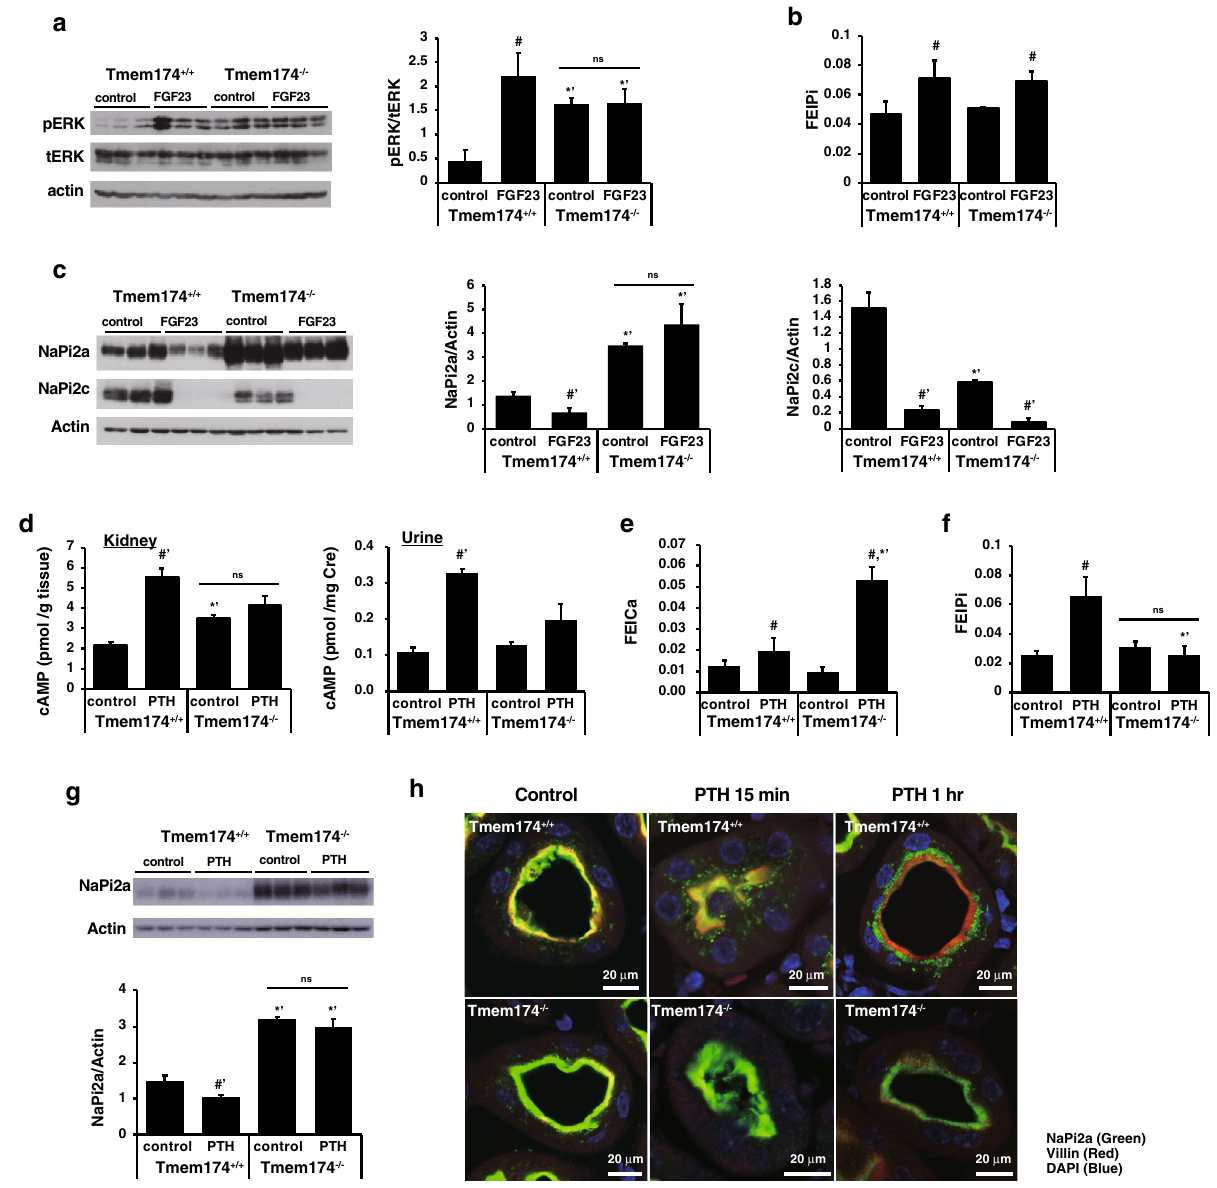
Figure 9. Abnormal regulation of phosphaturic action to renal NaPi2a Pi transporter in Tmem174 −/− mice. Tmem174 +/+ and Tmem174 −/− mice (9–10-week-old mice, n = 3–5, respectively) were fed a 0.02% low Pi diet for 7 days to reduce endogenous FGF23. Exogenous FGF23 expression was performed using the Naked- DNA method, as described previously 26 . ( a ) Western blotting analysis of total ERK1/2 and phosphorylation ERK1/2 in Tmem174 +/+ and Tmem174 −/− mice. Each lane was loaded with 20 μg of the whole homogenate. Values are mean ± SE. # p < 0.05 vs control of the same genotype, *’ p < 0.01 vs same treatment of Tmem174 +/+ mice. ns not significant. ( b ) FEIPi. Values are mean ± SE. # p < 0.05 vs control of the same genotype. ( c ) Western blot analysis of NaPi transporters in Tmem174 +/+ and Tmem174 −/− mice. Each lane was loaded with 20 μg of BBMVs. Actin was used as an internal control. *’ p < 0.01 vs same treatment of Tmem174 +/+ mice. Values are mean ± SE. #’ p < 0.01 vs control of the same genotype. ns not significant. Experiments were performed in triplicate. Tmem174 +/+ and Tmem174 −/− mice (9–10-week-old mice, n = 3–5, respectively) were fed a 0.1% low Pi diet for 7 days to reduce endogenous PTH. Bovine PTH (1–34) was administered to Tmem174 +/+ and Tmem174 −/− mice. Samples were collected after 15 min or 1 h administration of PTH. ( d ) cAMP level of the kidney and Urine of mice after 15 min PTH administration. ( e ) FEICa, ( f ) FEIPi. Samples were collected after 1 h administration of PTH. Values are mean ± SE. # p < 0.05 vs control of the same genotype. *’ p < 0.01 vs same treatment of Tmem174 +/+ mice. ns; not significant. ( g ) Western blot analysis of NaPi2a in Tmem174 +/+ and Tmem174 −/− mice. Each lane was loaded with 20 μg of BBMVs. Actin was used as an internal control. Values are mean ± SE. #’ p < 0.01 vs control of the same genotype. *’ p < 0.01 vs same treatment of Tmem174 +/+ mice. ns not significant. ( h ) Immunostaining of renal NaPi2a (Green) localization in the kidney sections of mice 15 min and 1 h after administration of PTH. DAPI (Blue). Villin (Red). Experiments were performed in